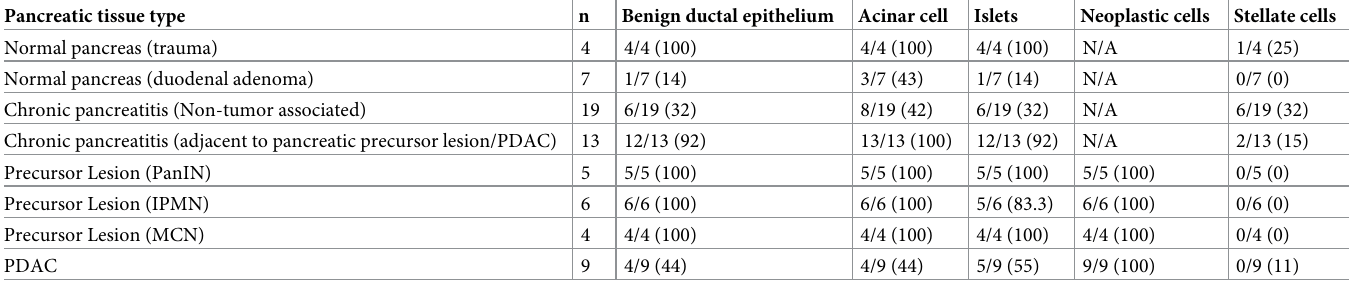
Table 2. Labeling characteristics for RNLS immunohistochemistry